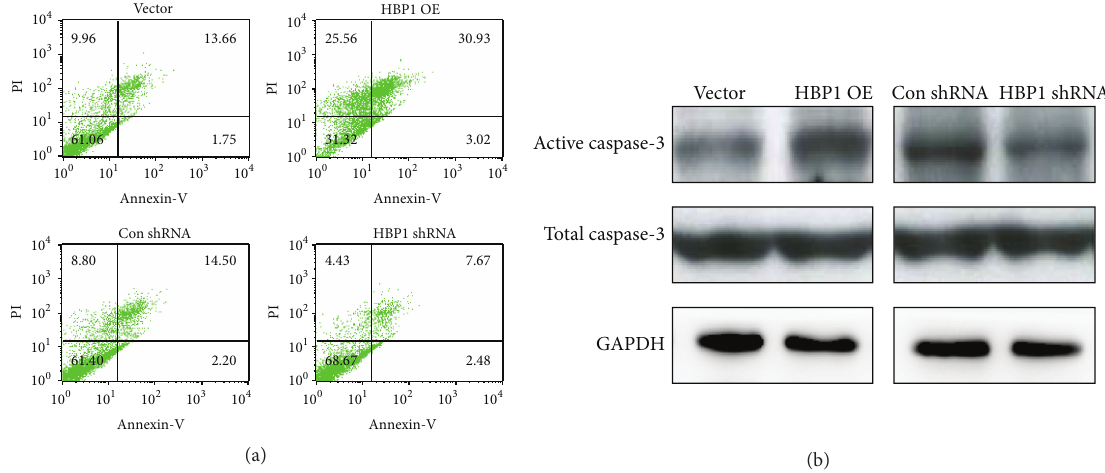
Figure 3: Apoptosis of DU-145 cells with different expression levels of HBP1 gene. (a) Flow cytometry assay was used to detect the apoptosis in Vector, HBP1 OE, Con shRNA, and HBP1 shRNA groups 48 h after irradiation with 4 Gy. (b) Western blot assay was used to detect the activity of proapoptotic protein caspase-3.